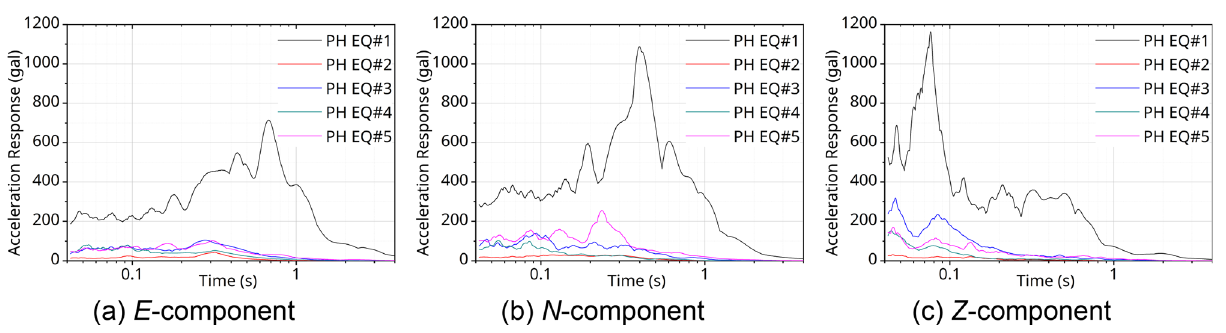
Figure 7. Response spectra @PHT with PH EQs.